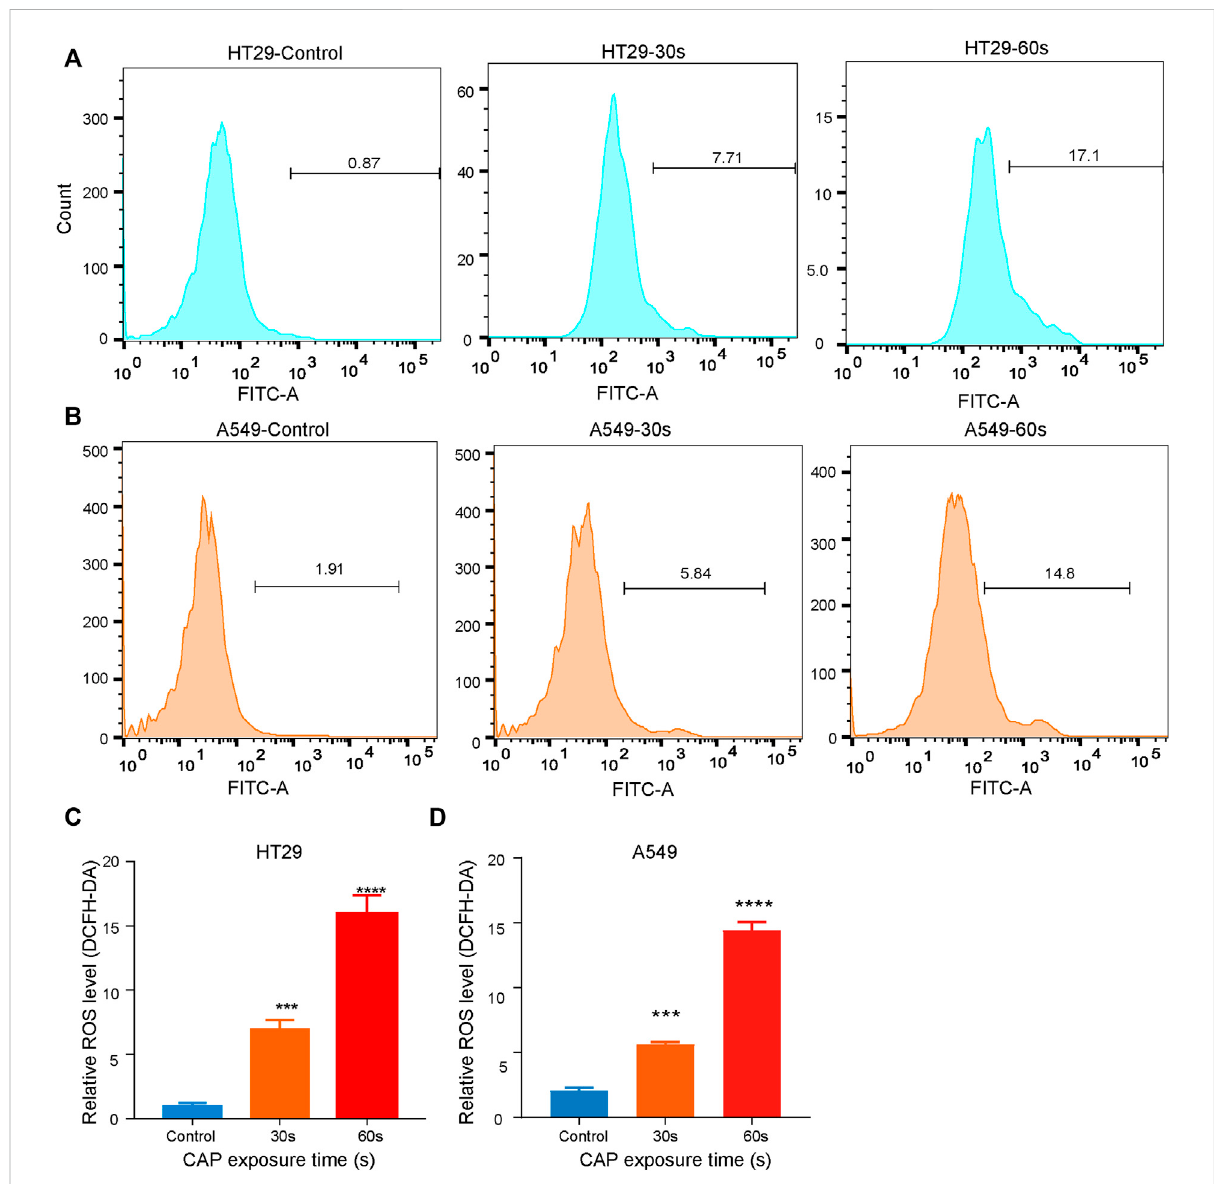
FIGURE 6 Dose-dependent and CAP PZ2 -induced ROS accumulation in the HT29 and A549 cells. (A, B) Flow cytometric analysis of intracellular ROS after DCFH-DA incubation with cells treated using CAP PZ2 at 30 and 60 s. (C, D) Histogram showing the proportion of ROS negative cells after different plasma treatment duration. Student ’ s t-test was performed (*** p < 0.001 and **** p <